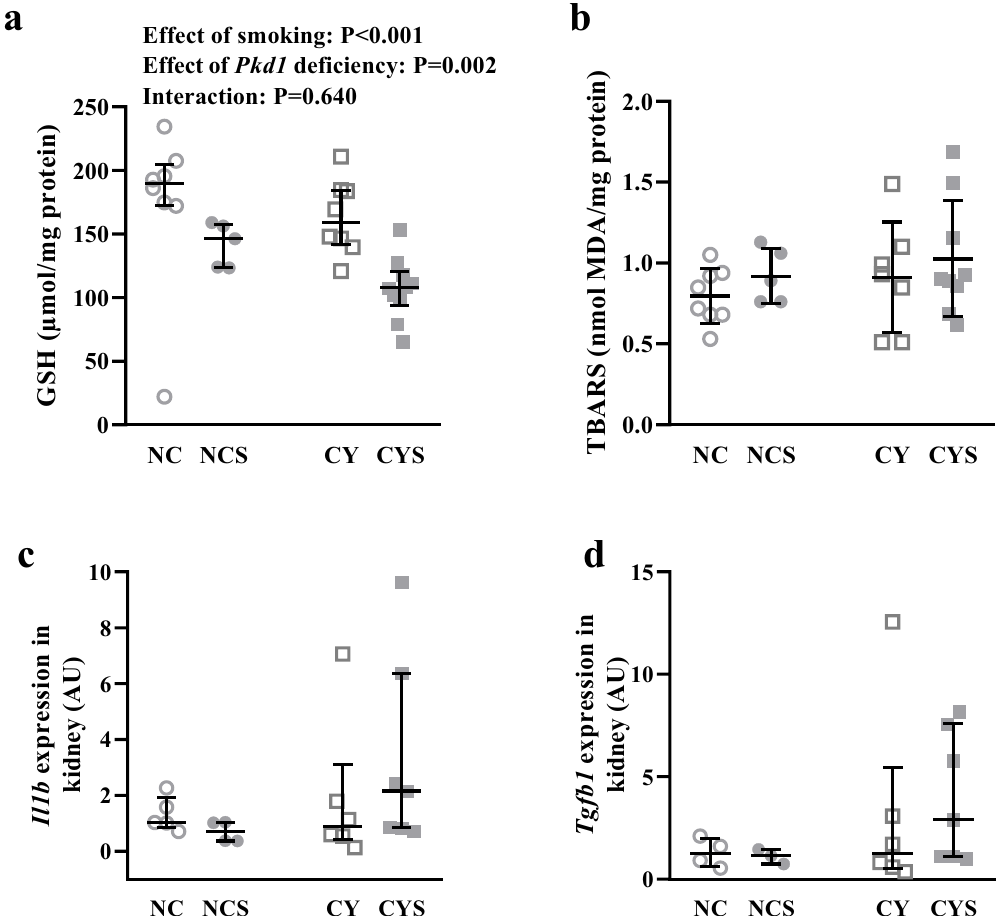
Figure 7. ( a ) Analysis of the effects of smoking and Pkd1 deficiency in the renal glutathione (GSH) levels on NC (n = 8), NCS (n = 5), CY (n = 8) and CYS (n = 10) mice. ( b ) Analysis of the effects of smoking and Pkd1 deficiency in the renal thiobarbituric acid reactive substances (TBARS) levels on NC (n = 8), NCS (n = 5), CY (n = 7) and CYS (n = 9) animals. ( c ) Analyses of the effects of smoking and Pkd1 deficiency in Il1b expression in renal tissue on NC (n = 5), NCS (n = 4), CY (n = 6) and CYS (n = 7) mice; and ( d ) in tgfb1 expression in renal tissue on NC (n = 5), NCS (n = 3), CY (n = 6) and CYS (n = 7) animals. The data were analyzed by aligned rank transform followed by two-way analysis of variance ( a , c , d ) and by two-way analysis of variance ( b